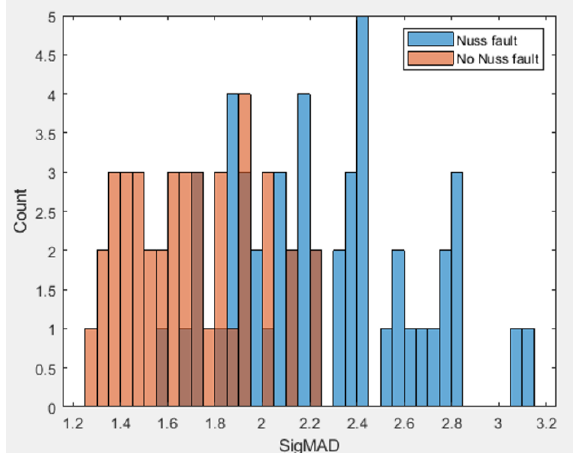
Fig. 1 1 . Histograms for the Nuss factor (the effect of icing on changes in the performance of Nuss sensors) according to the MAD